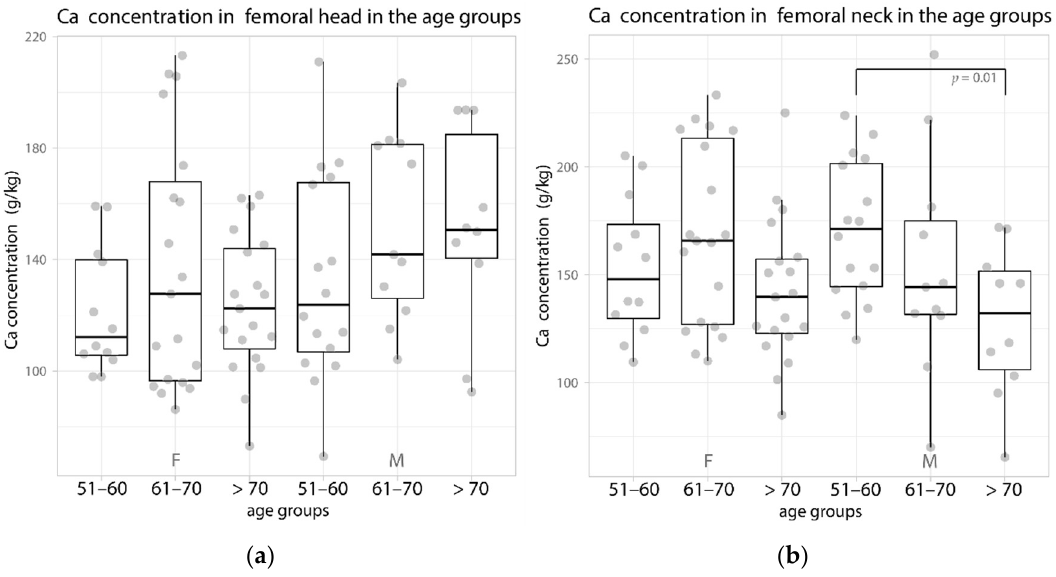
Figure 1. Data distribution (jittered dots) and boxplot of the median Ca content (in g/kg) in the age groups in women and men in the femoral ( a ) head and ( b ) neck. F—female, M—male. Table 2. Number of patients, BMI (kg/m 2 ), and weight (kg) (mean ± SD and median (Q1–Q3)) of the patients in the sex and age groups ( N = 86).